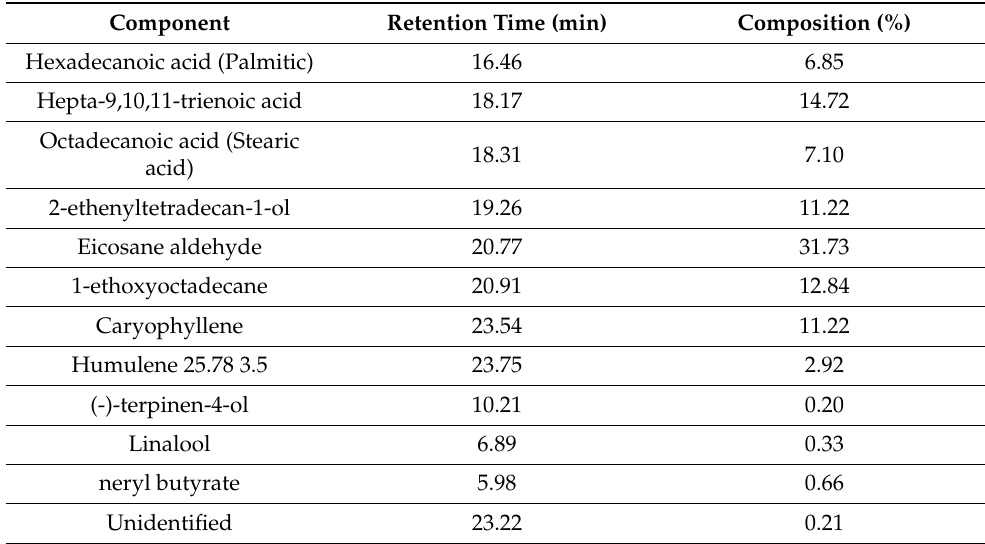
Table 5. Identification of Cymbopogon citratus aqueous extract bioactive compounds.